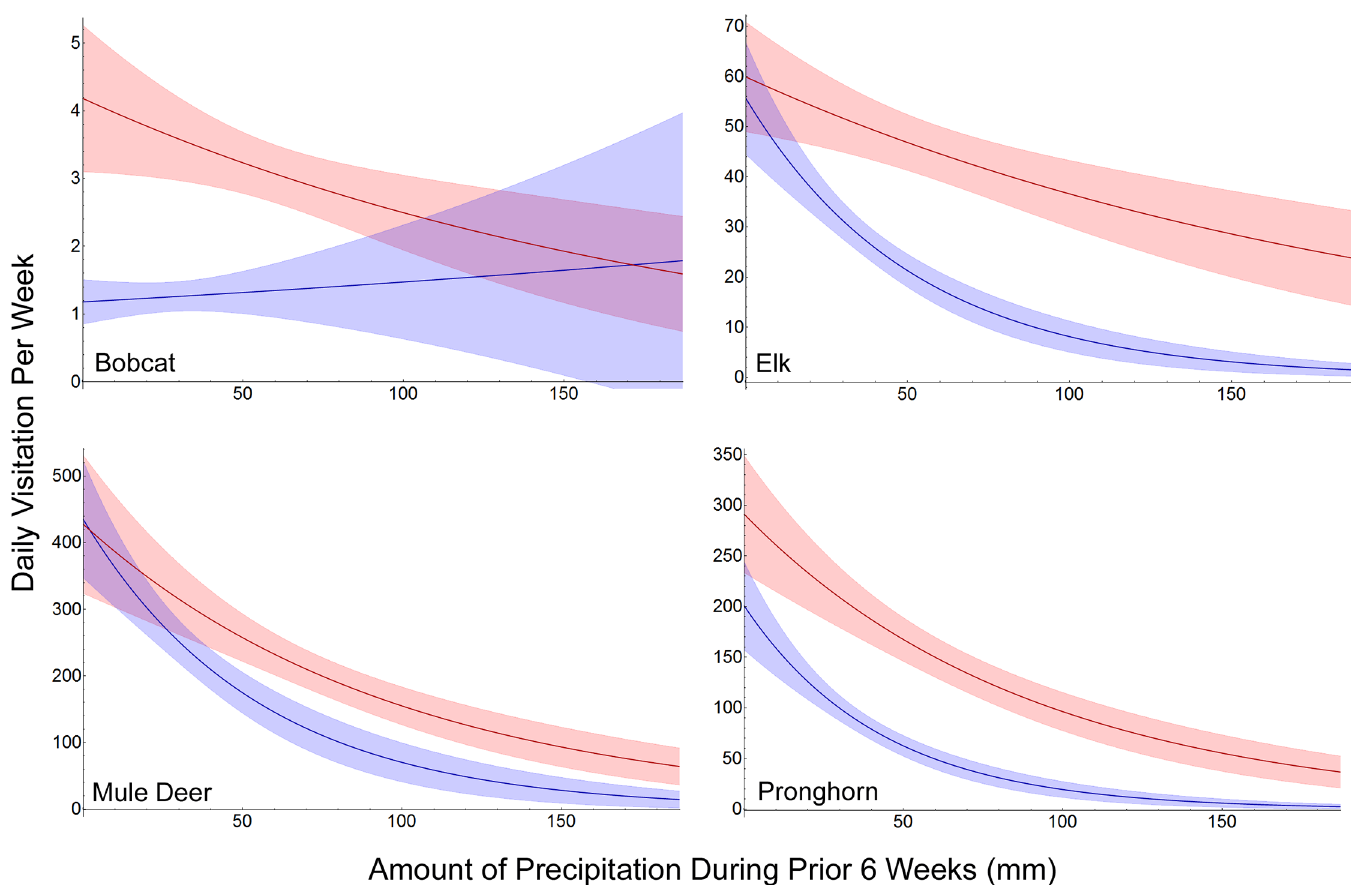
Fig 1. Variable Interaction. Interaction between maximum temperature (weekly average) and long-term precipitation (6-week total) in the models receiving most support (lowest AIC) for predicting visitation to water for bobcat, elk, mule deer and pronghorn inhabiting Sevilleta National Wildlife Refuge, New Mexico, USA. Blue indicates the model prediction with maximum temperature held at the lower quartile. Red indicates the model prediction with maximum temperature held at the upper quartile. Shading colors the 95% confidence interval for the predictions describing the amount of visitation to water.